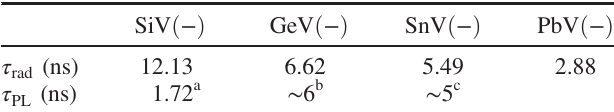
TABLE II. The calculated radiative lifetimes ( τ centers at cryogenic temperatures. We use the experimental ZPL energy where available in the calculation of τ involves both radiative and nonradiative